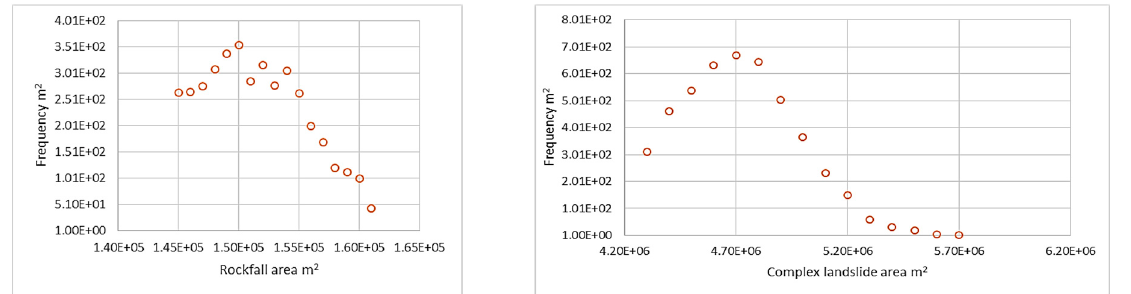
Figure 9. Frequency-area distribution of landslides in the study area.